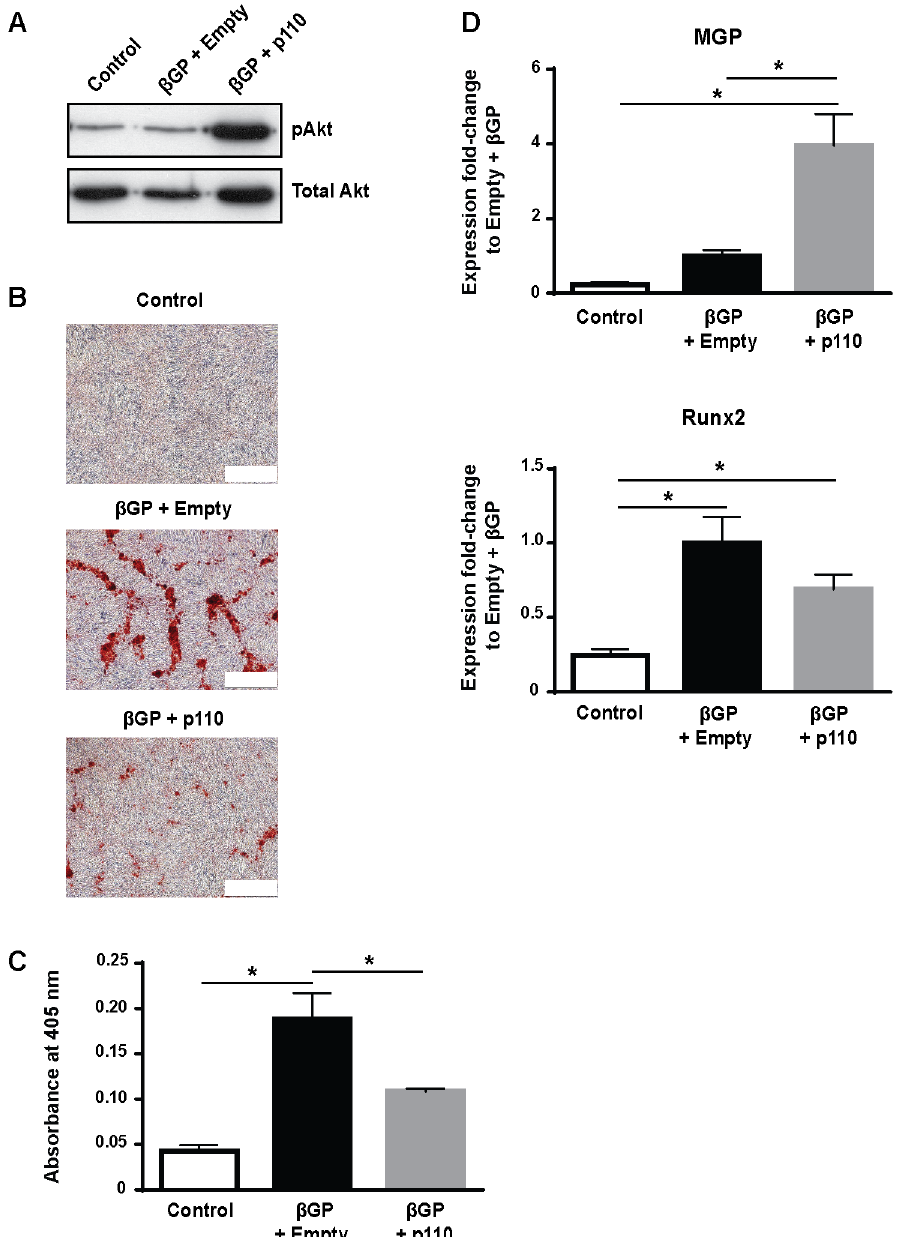
Fig 4. Over-expression of constitutively activated p110 sub-unit of PI3K inhibits mineralization. Constitutively active p110 sub-unit of PI3K (p110) or empty virus (Empty) were over-expressed in VSMC using adenovirus and cells were incubated in 10% FCS-DMEM containing β GP (5 mM) for 9 days. Controls were incubated without BGP. ( A ) Representative western blots of cell lysates for pAkt and total Akt. ( B ) Representative phase contrast images of alizarin red-stained cells (bar = 500 μm). ( C ) Quantification of mineralization (mean ± SEM; n = 6). Data were normalized using log 10 and analyzed using one-way ANOVA and Tukey post-hoc tests; (cid:3) p < 0.05 compared to β GP. ( D ) qPCR for Runx2 and matrix Gla protein (MGP) was performed. Relative mRNA expression of Runx2 and MGP are shown as fold-change to cells treated with empty virus and β GP (mean ± SEM; n = 6). Data were analyzed using one-way ANOVA and Tukey post-hoc tests; (cid:3) p < 0.05.